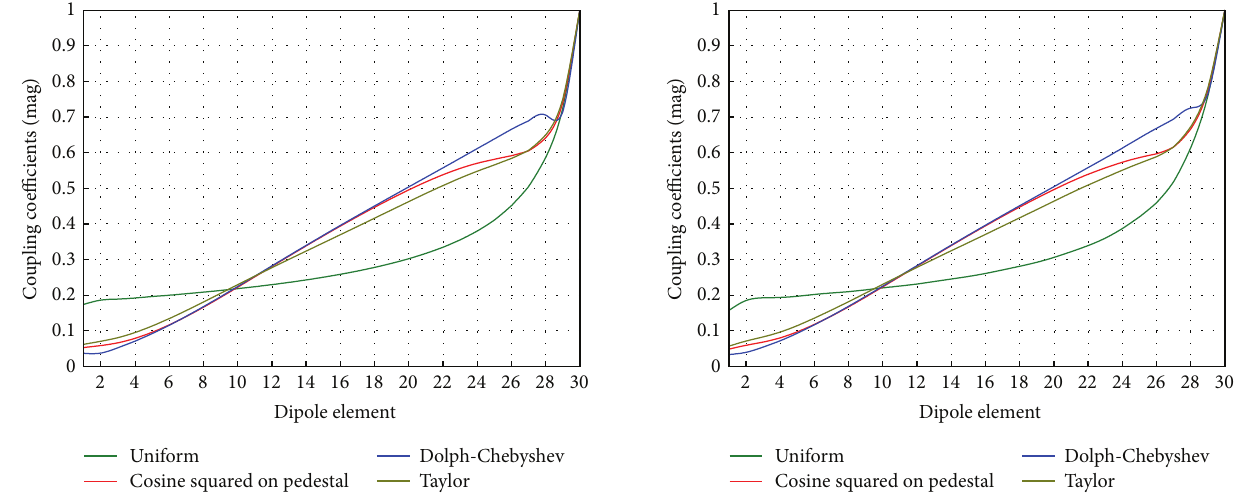
Figure 8: Coupling coefficients for different amplitude distributions in a series-fed linear dipole array; parallel-in-echelon configuration. 𝑑 = 0.1 𝜆